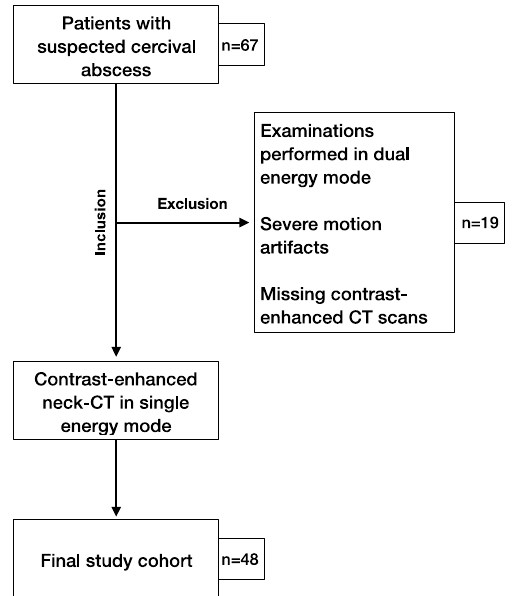
Figure 1. Study flowchart of patient inclusion.